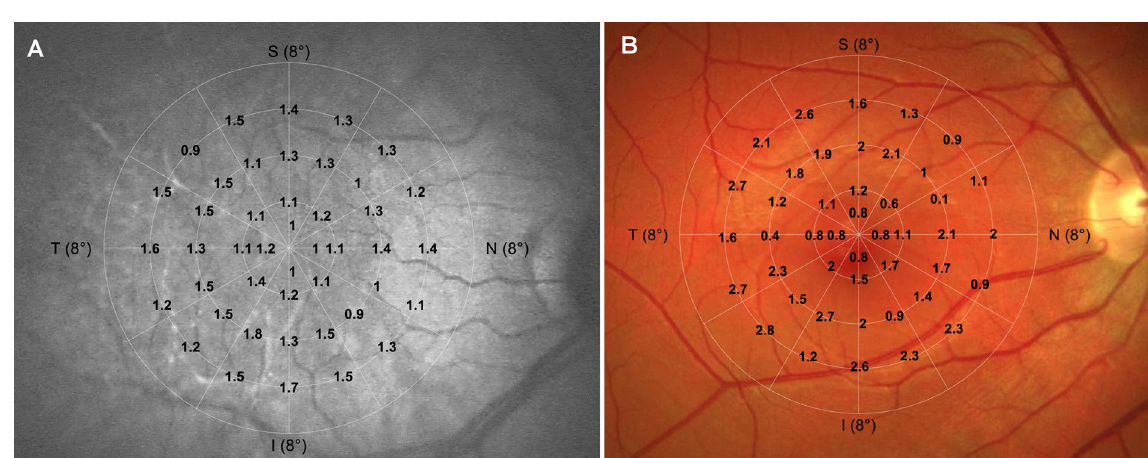
Figure 3. The absolute difference between IR- ( A ) and visible-light ( B ) sensitivity measured at each retinal location. The test grid was projected on an exemplary fundus image obtained with an SLO ( A ) and a standard photographic ( B ) technique.